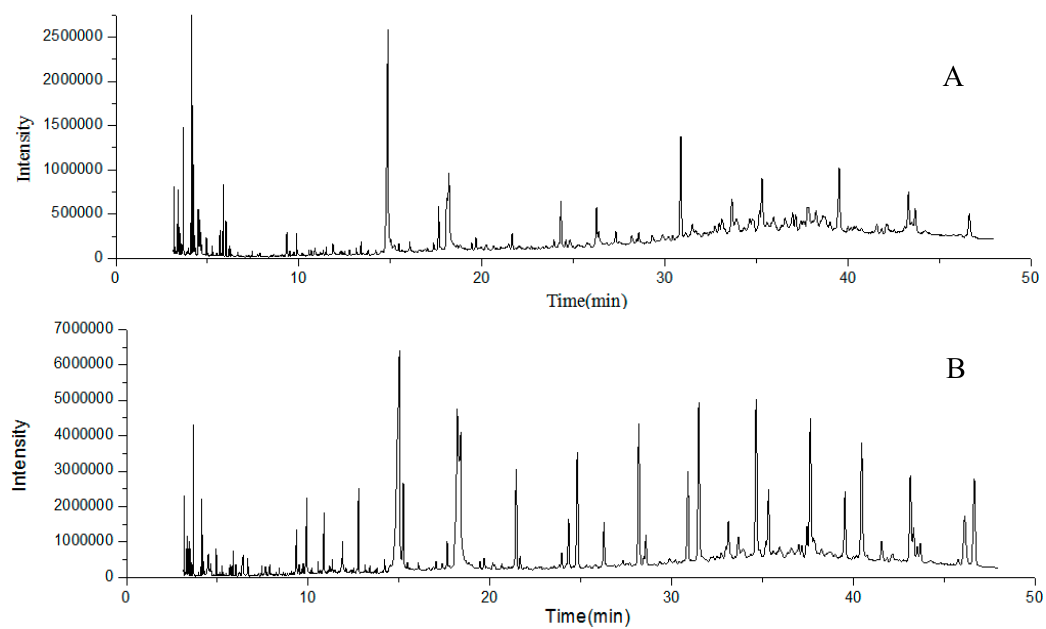
Figure 2. The representative total ion chromatograms of R. roxburghii ( A ) and R. sterilis ( B ) fruits obtained from GC-MS analysis.